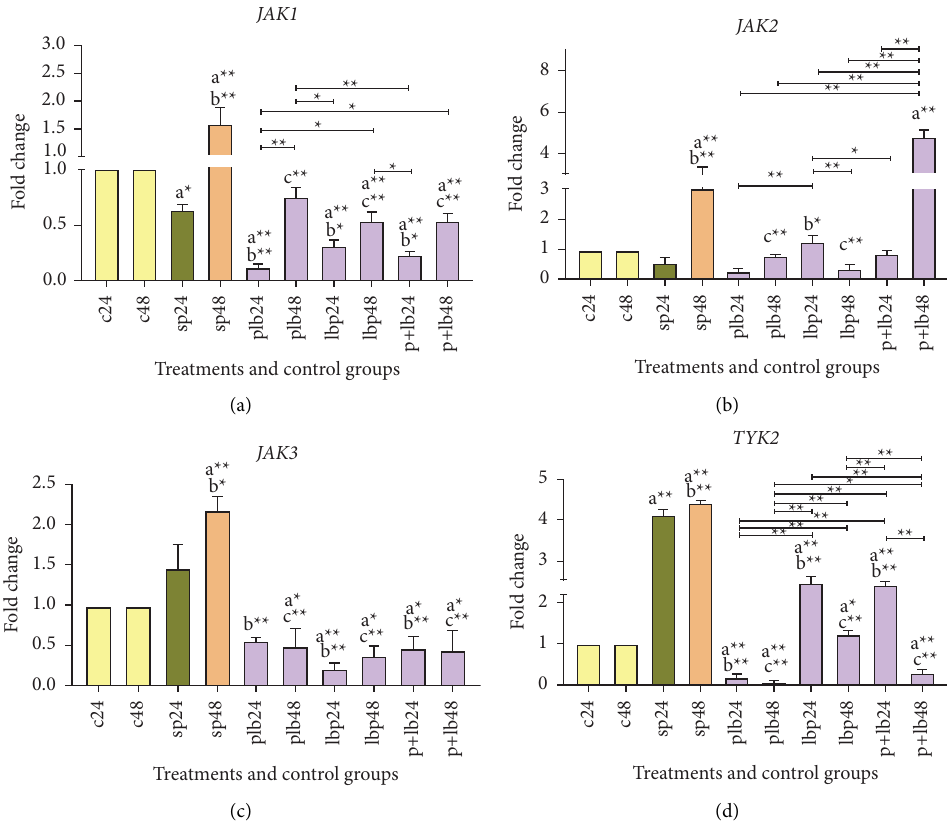
Figure 2: Relative gene expression (mean fold change) of (a) JAK1 , (b) JAK2 , (c) JAK3 , (d), and (e) TYK2 in the diferent groups of treatments. Data were normalized with GAPDH . Data were represented as mean SD. Te number 24 and 48 refers to diferent time orders of HT-29cell line treatments. (C) represents control; (P) represents pathogen; PLB represents frst pathogen and then Lactobacillus/Bif- dobacterium ; LBP represents frst Lactobacillus/Bifdobacterium and then sonicated pathogen; P+LB represents sonicated pathogen and then Lactobacillus/Bifdobacterium added simultaneously. Data were considered statistically signifcant when p < 0 . 05 ( ∗ p < 0 . 05, ∗∗ p < 0 . 001). Letter (a) indicates the relatedness between C24 and C48 with other treatments, letter (b) shows the relatedness between sp24 and other treatments, and letter (c) shows the relatedness between sp48 with other treatments. Te relatedness between other treatments is shown with